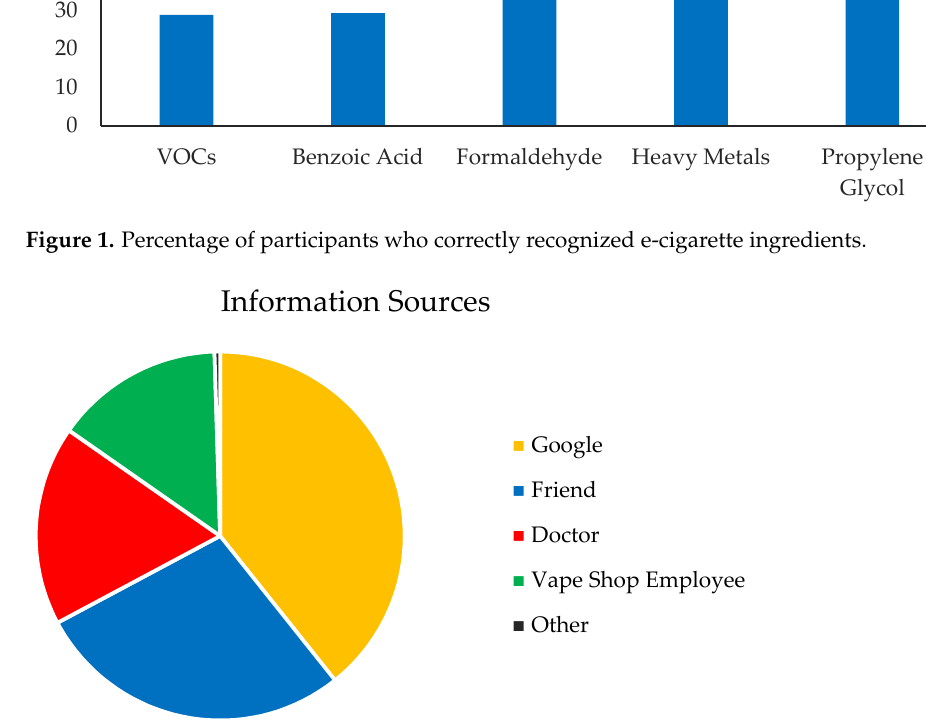
Figure 2. Percentage of participants who chose each source of e-cigarette information.